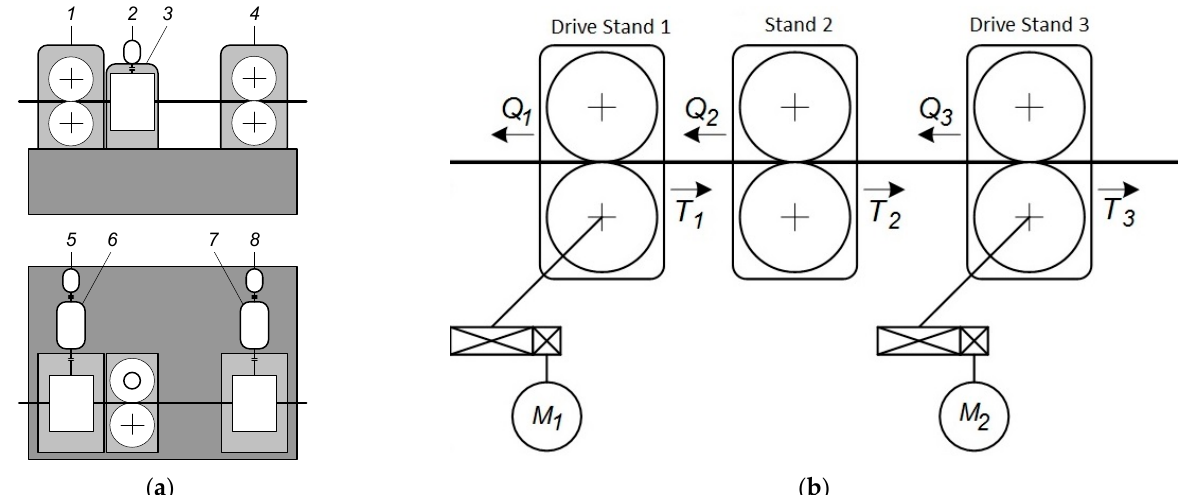
Figure 2. Equipment arrangement ( a ) and kinematic diagram ( b ) of a continuous three-stand rolling section (block): 1 and 4, drive stands; 3, idle stand; 6 and 7, electric motors; 2, 5, and 8, velocity generators.